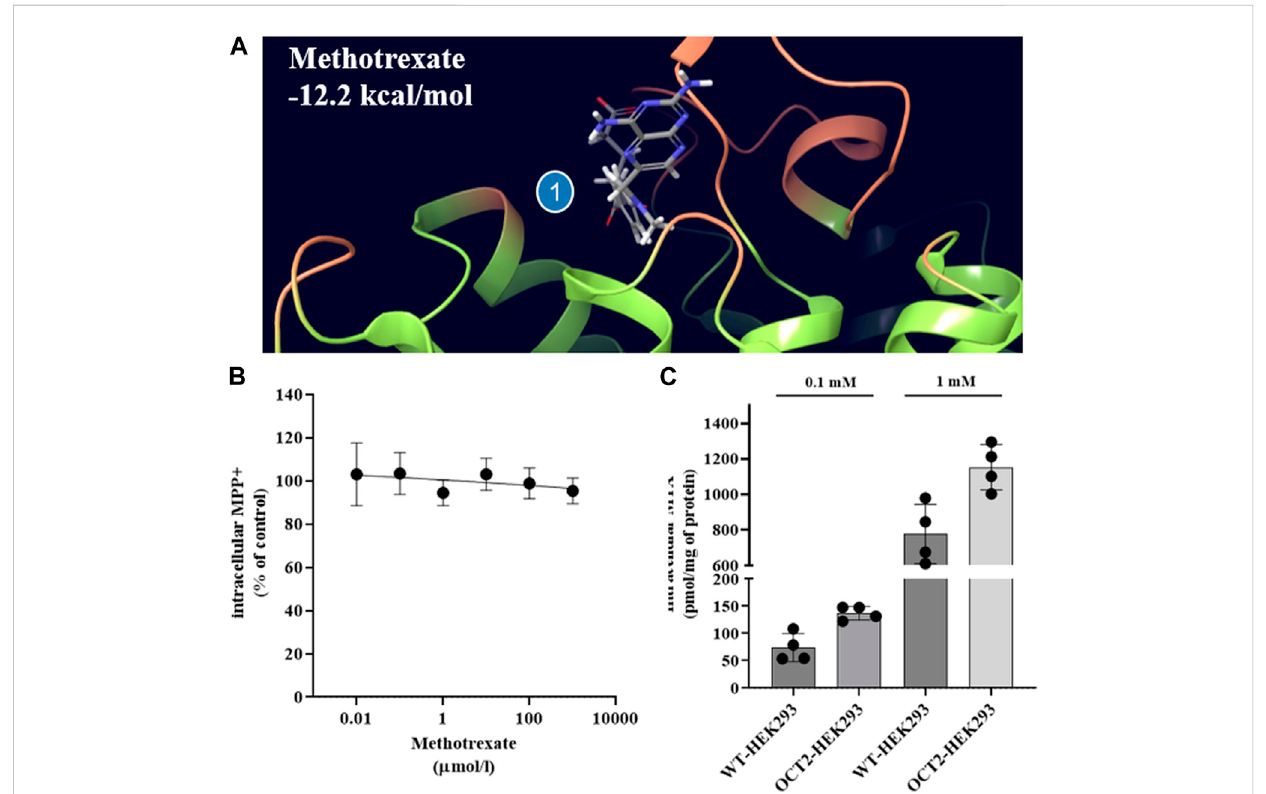
FIGURE 7 OCT2-MTXinteractioninintactcells.BindingposeandestimatedbindingfreeenergyofMTXtopredictedbindingsiteoneofOCT2 (A) .Ten-second uptake of MPP + at the extracellular concentration of 0.5 µM in OCT2-HEK293 cells in the presence of increasing extracellular concentrations of methotrexate (MTX). TheuptakevaluemeasuredinOCT2-HEK293 cells inthepresenceof non-labelled MPP + attheextracellular concentration of1 mM was subtracted to de fi ne the OCT2-speci fi c transport. Data are expressed as percentage of the uptake value in vehicle-treated cells (control) and representthemean±SDfromtwoindependentexperimentsperformedinduplicate (B) .One-minuteuptakeofMTXattheextracellularconcentrationof 1 mM in WT- and OCT2-HEK293 cells. p -value was calculated from unpaired t -test comparison of the mean ± SD from two independent experiments performed in duplicate (C)